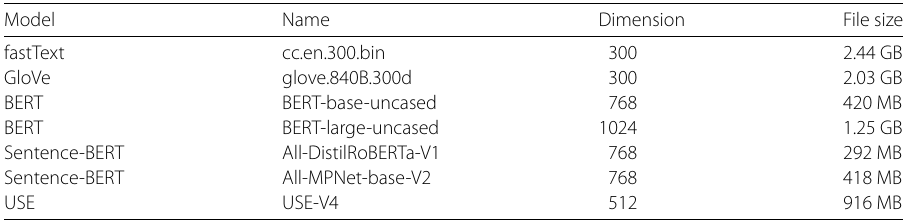
Table 1 Overview of Pretrained Text Embedding Models Investigated in this Study